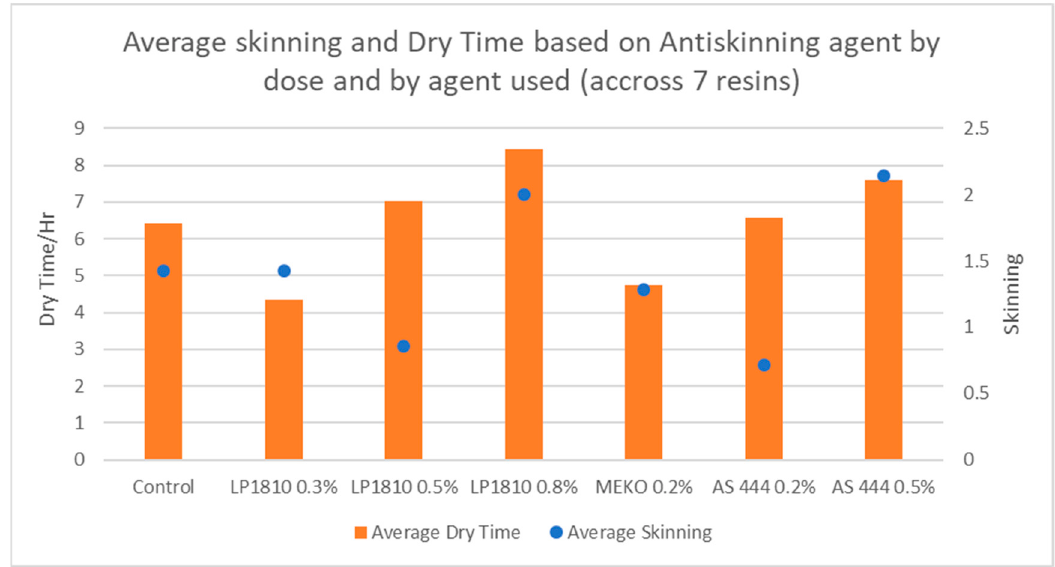
Figure 18. Average skinning (shown as blue dots) and dry times (shown as orange bars) of seven resins using anti-skinning agents with Borchi® Oxy Coat Fe-bispidon catalyst. Seven commercial, high-oil alkyds were used, and an average dry time and skinning was taken for each anti-skinning agent. Formulations were mixed using a speed mixer DAC 150.FVZ at 3500 RPM for 1.5 min and left for 24 h before being applied to glass plates at 100 μ M. Dry time conditions: 23 °C at 50% relative humidity. In all cases 0.5% ( w / w ) of a 1% ( w / w ) Fe-bispidon catalyst dissolved in propylene glycol was added, together with an anti-skinning agent, LP1810, MEKO, or AS0444 was added in the amounts given in the figure. LP1810 is a mixture of 12% Cerium hex Cem and Borchi® Nox C3, MEKO is methylethylketoxime and AS0444 is Borchers® Ascinin 0444 from Borchers. Skinning is a qualitative scale where 0 = no change, 1 = very thin skin, 2 = thin skin, 3 = medium-thin, 4 = hard skin, 5 = very hard skin.